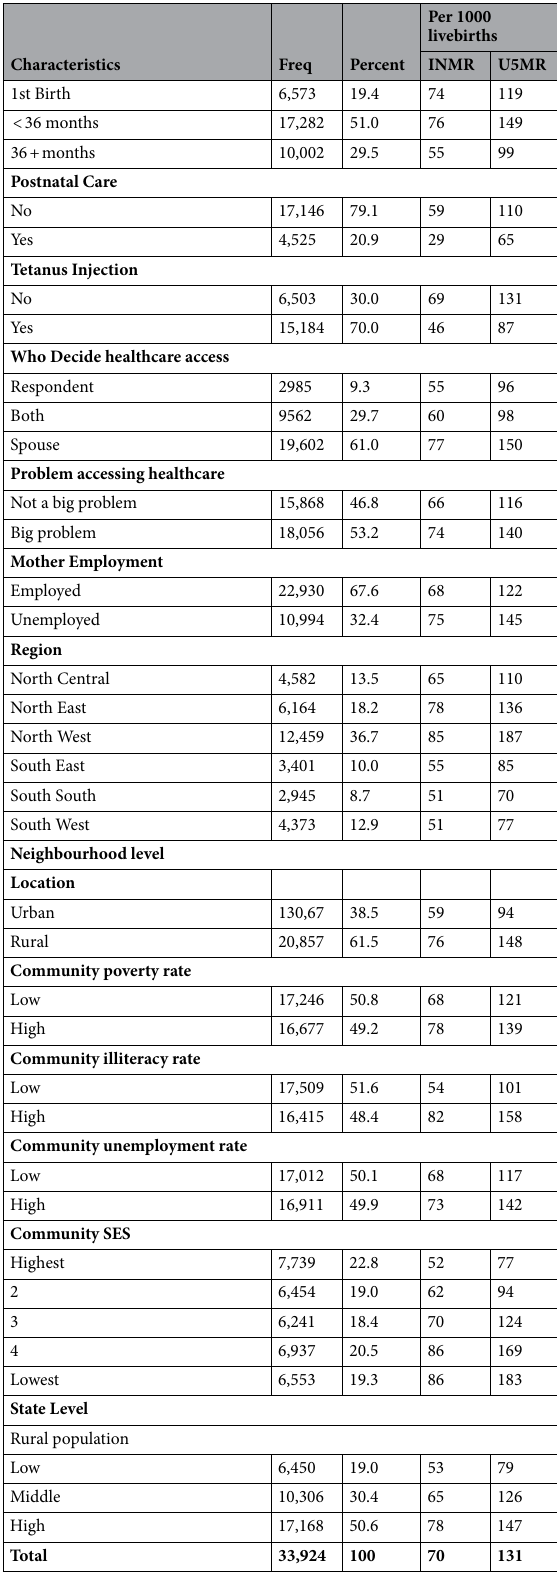
Table 1. Distribution of children aged 0–59 months, infant mortality and under-five mortality by individual-, neighbourhood- and state-level factors in Nigeria. INMR Infant Mortality Rate, U5MR Under-five Mortality Rate, SES socio-economic